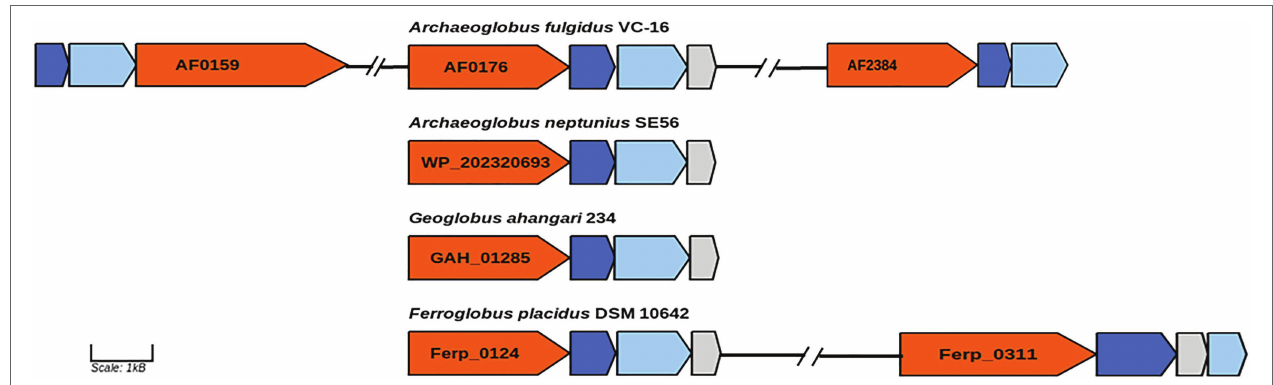
FIGURE 4 | Genes of molybdopterin oxidoreductases probably involved in perchlorate and nitrate reduction. Orange, molybdopterin oxidoreductase molybdopterin binding subunit; blue, molybdopterin-containing oxidoreductase family iron–sulfur binding subunit; light blue, molybdopterin-containing oxidoreductase family membrane subunit; and gray: molybdenum cofactor insertion protein. GenBank accession numbers of catalytic subunits of each enzyme are